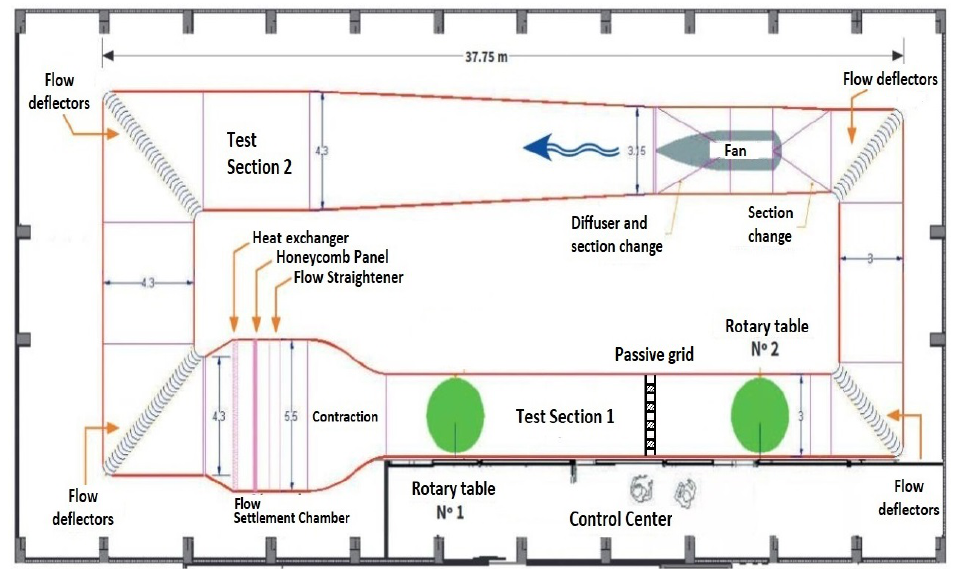
Figure 11. Atmospheric boundary layer wind tunnel of the II-UNAM and FiiDEM Alliance. The ex- periments were carried out in rotary table 2; the passive grid was fixed to 5 m upstream of the